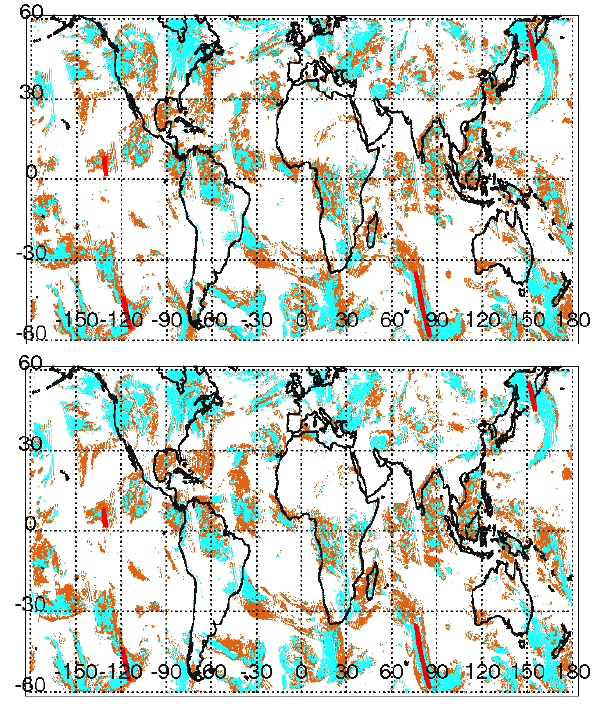
Fig. 6. Results of multi-layer detection for 13 November 2006. Top: MODIS-only (on the OMI footprint); Bottom: OMI/MODIS; Light blue: Vertically-extended; Orange: Distinct multi-layer; Red thick lines: Selected CloudSat orbital